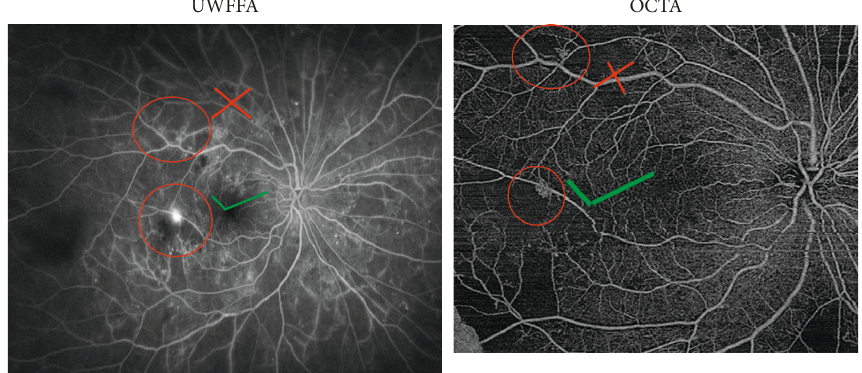
Figure 2: Example of a retinal NV site incorrectly identified (i.e., a false positive) on en face OCTA by one of the graders. Only one of the two NV sites identified on OCTA (the site with the green check-mark) was confirmed on the UWF-FA scan; the other site (with the red “X”) was not confirmed on UWF-FA.